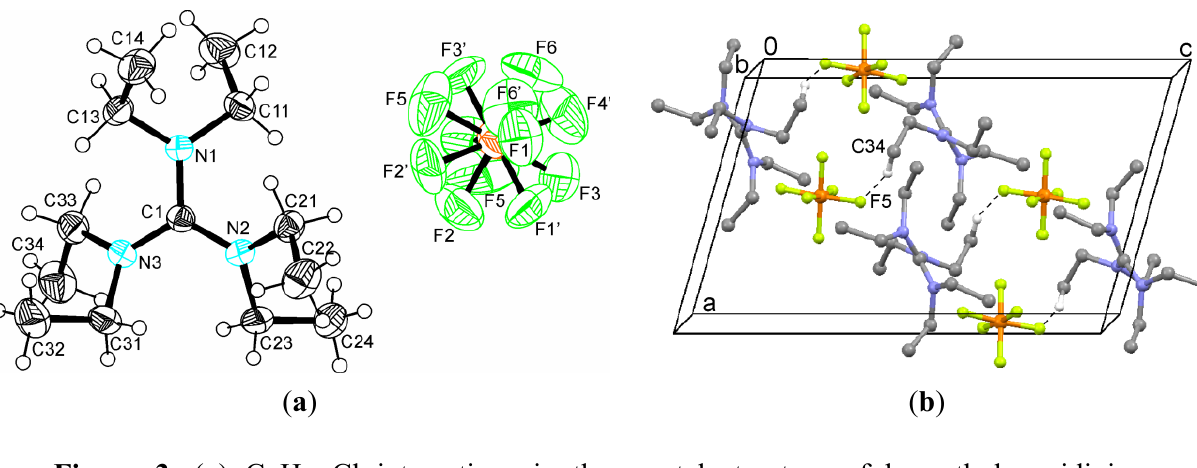
Figure 3. ( a ) C–H ··· Cl interactions in the crystal structure of hexaethylguanidinium tetrachloroferrate(III) ( 2 ); ( b ) C–H ··· Cl interactions in the crystal structure of hexaethylguanidinium tetrachlorocuprate(II) hydrate ( 3 ). Hydrogen atoms have been omitted for clarity, except for those engaged in